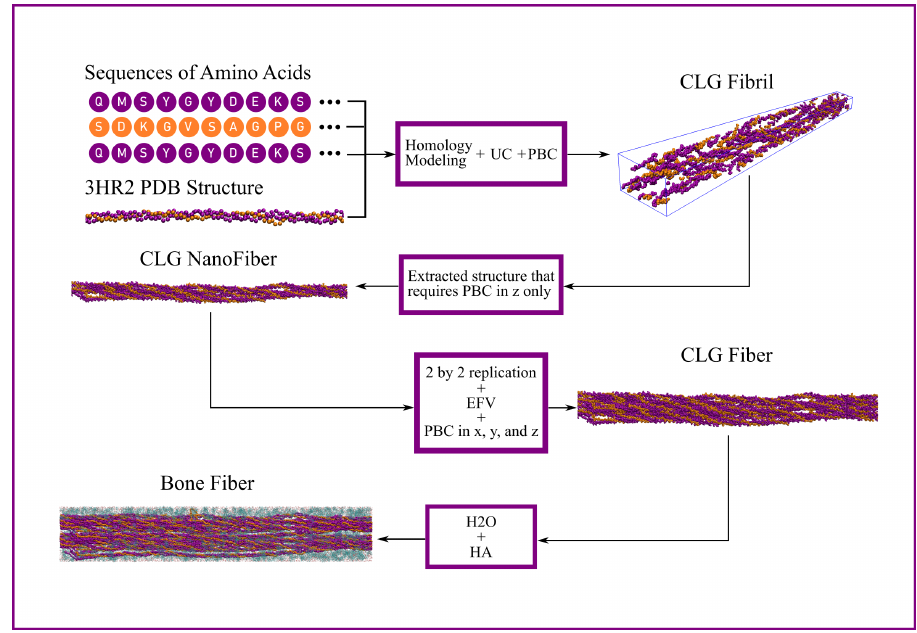
Figure 2. Schematic view of the modeling of a structure that resembles fibers in